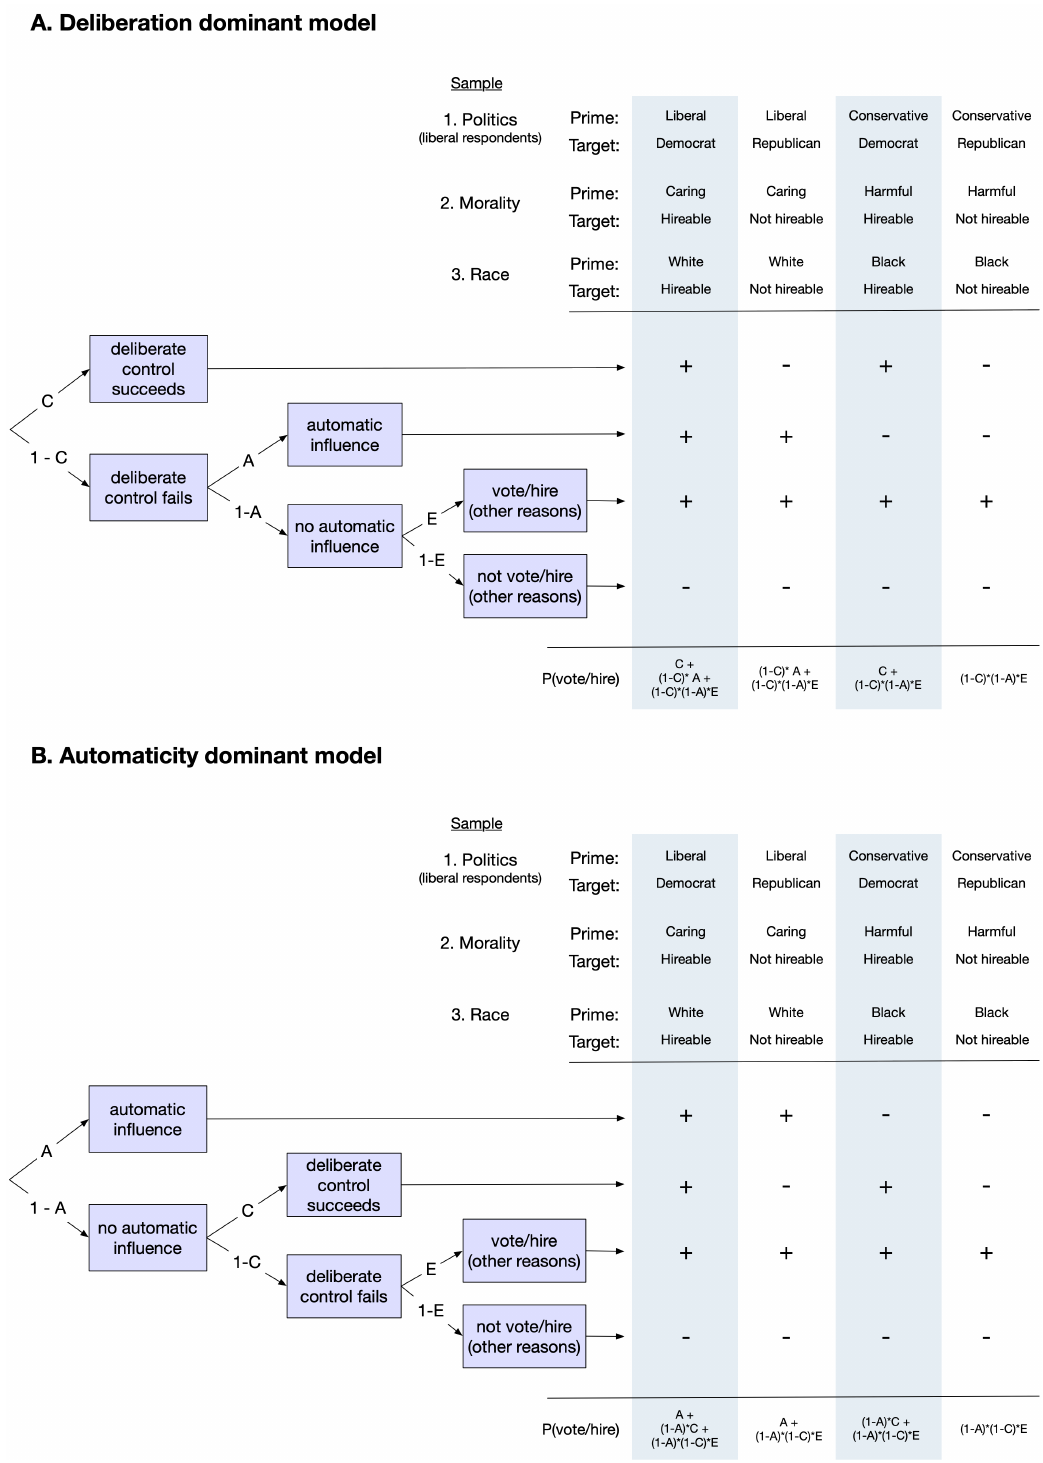
Figure 4: Deliberation- and automaticity-dominant models fit to samples from Miles et al.